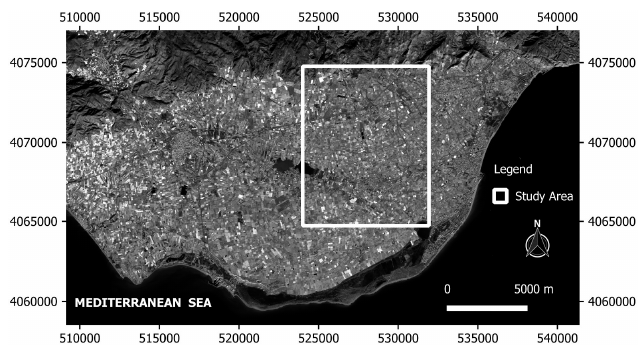
Figure 2. Location of the study area depicted by means of the Red band of the Sentinel-2 image (T30SWF granule). Coordinate system: ETRS89 UTM Zone 30N.